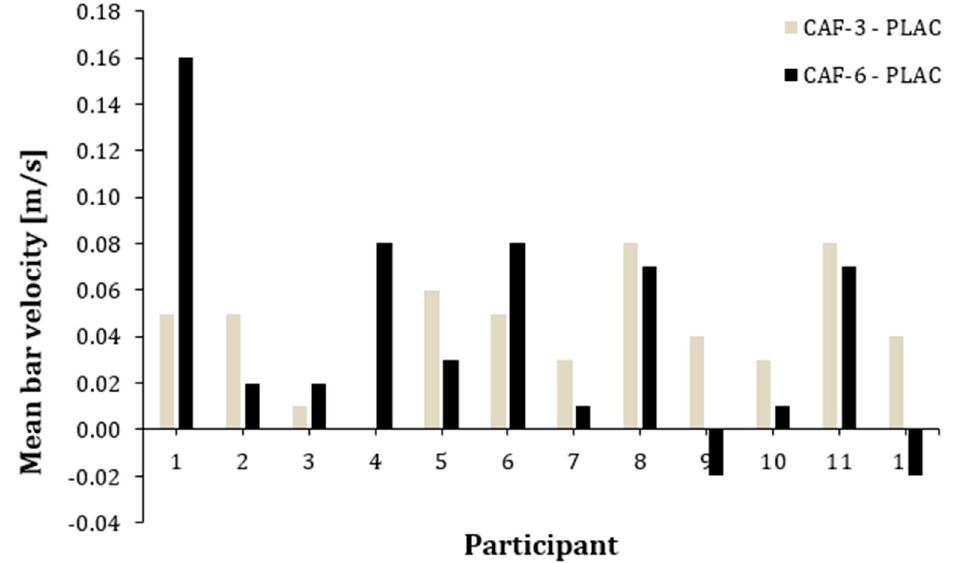
Figure 3. Individual differences in mean bar velocity during 5 sets of bench press throw (BPT) between caffeine and placebo conditions.